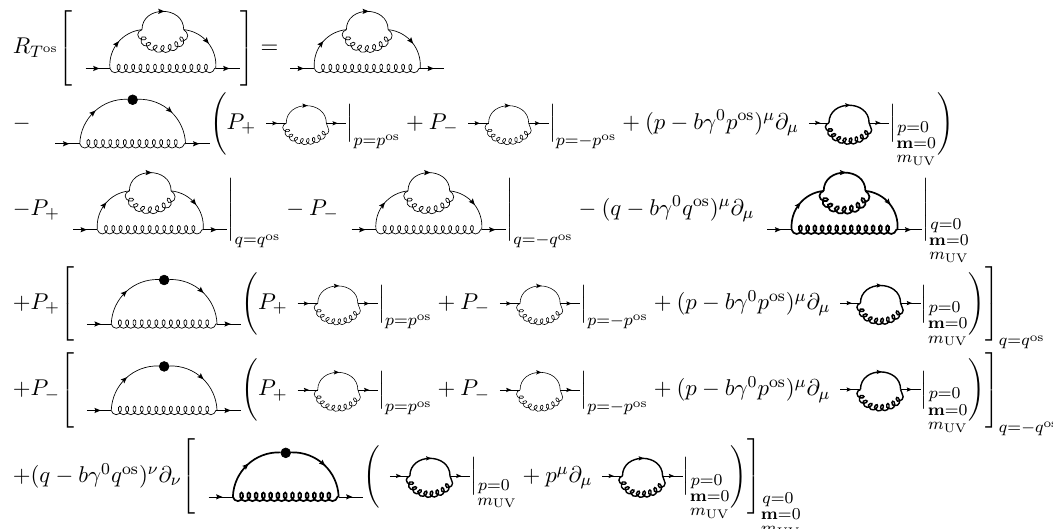
Figure 11. On-shell subtraction of a massive quark self-energy correction nested within a massive quark self-energy correction, performed using the approximation operator T os . The four-momentum p (resp. q ) corresponds to the external momentum of the inner (resp. outter) self-energy